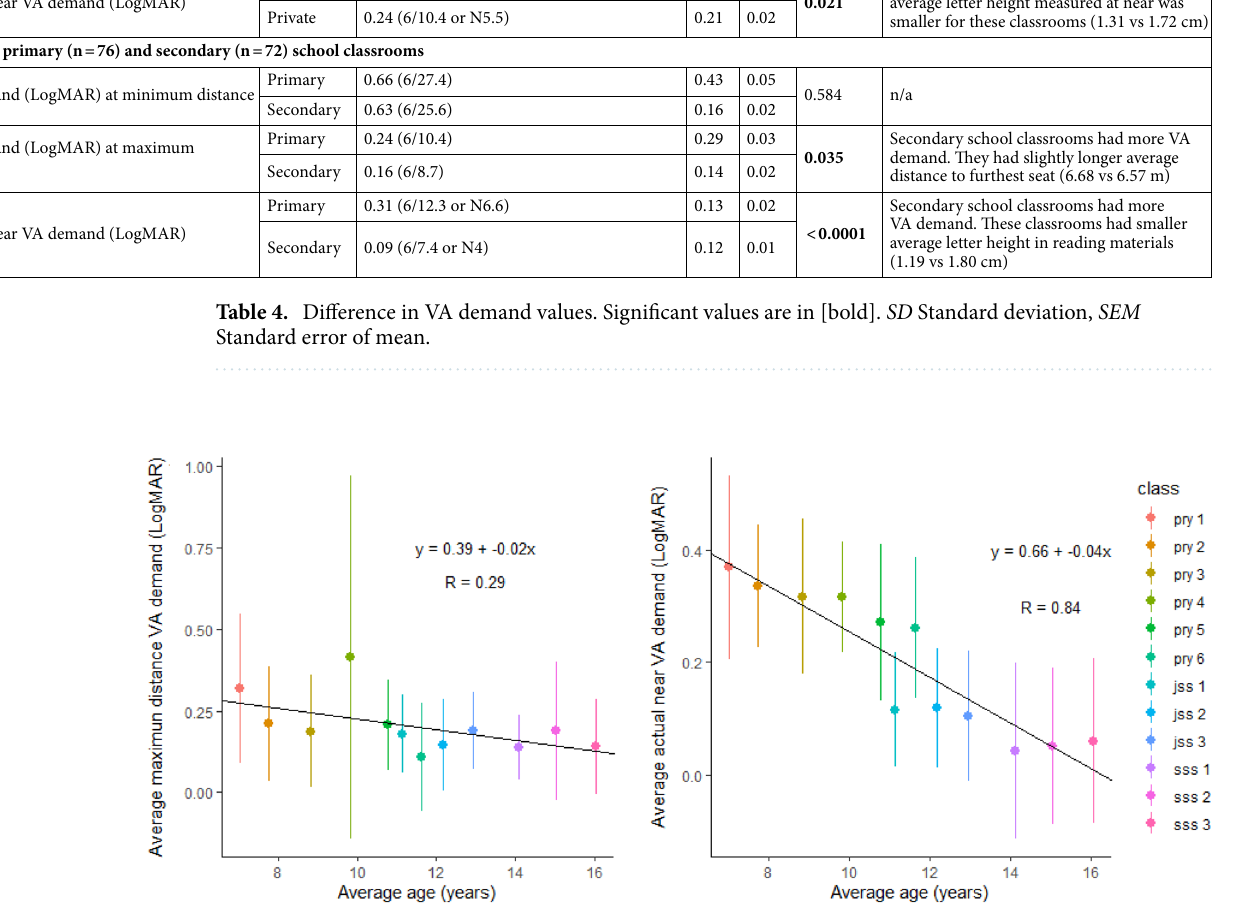
Figure 3. Average maximum distance VA demand (left) and average actual VA demand (right), as it relates to the average age of students per